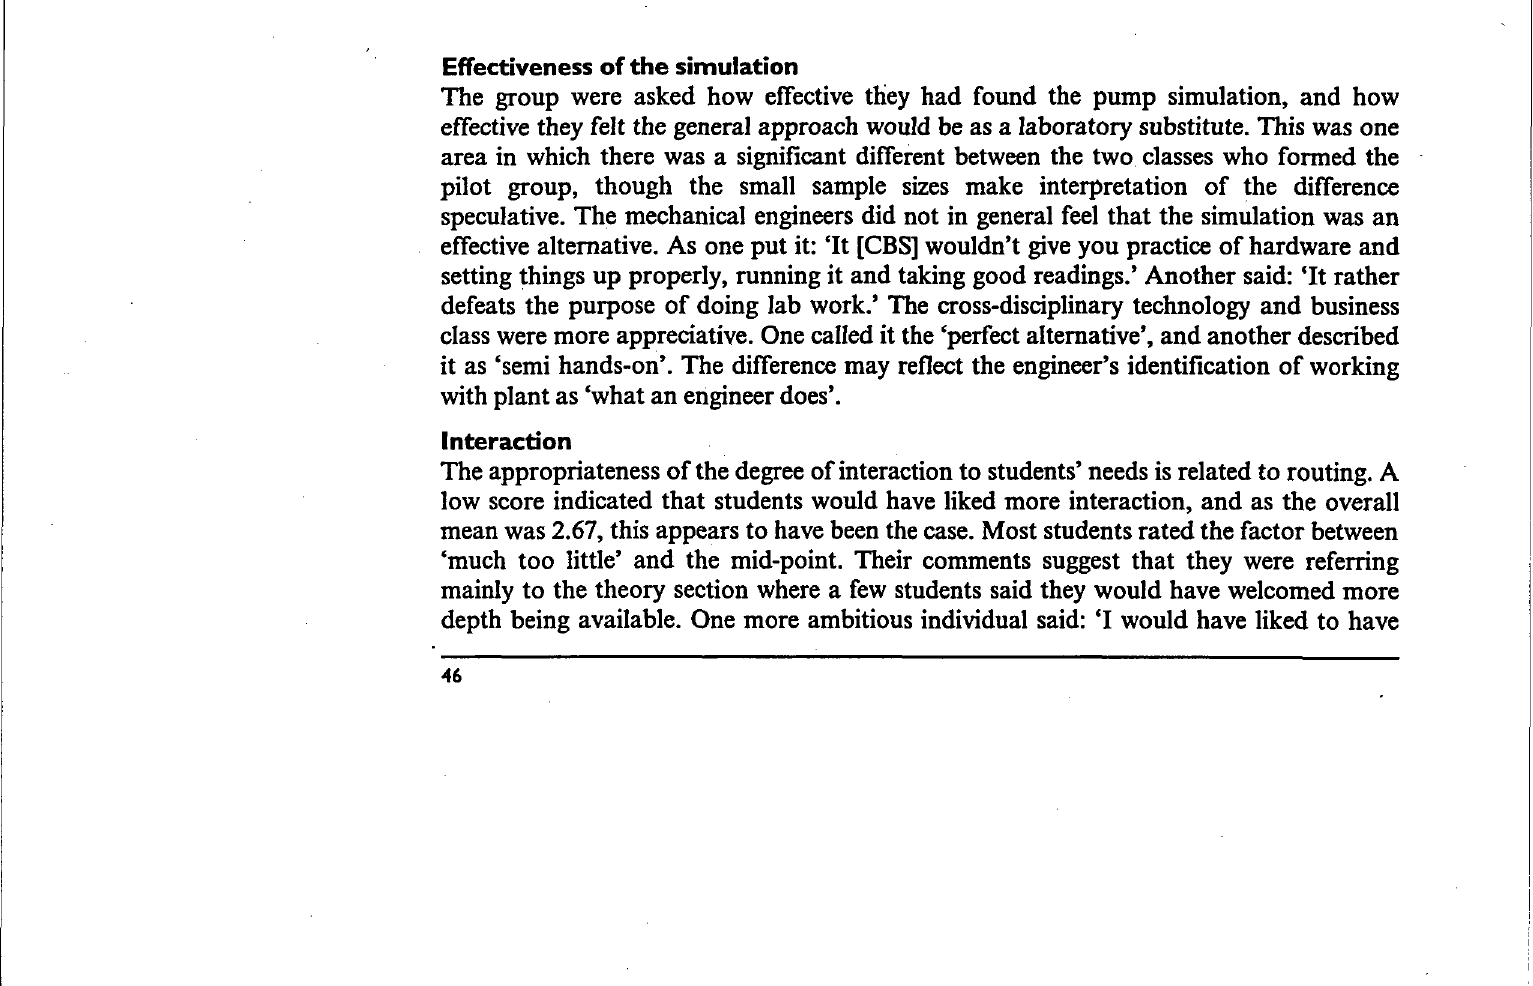
figure 3: Length of time spent by students of both groups on the activity